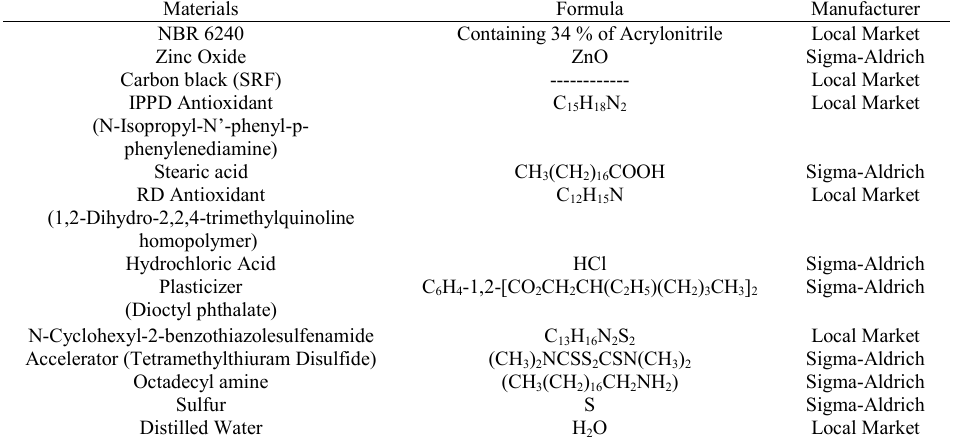
Table 1. Materials used to prepare nanocomposites.